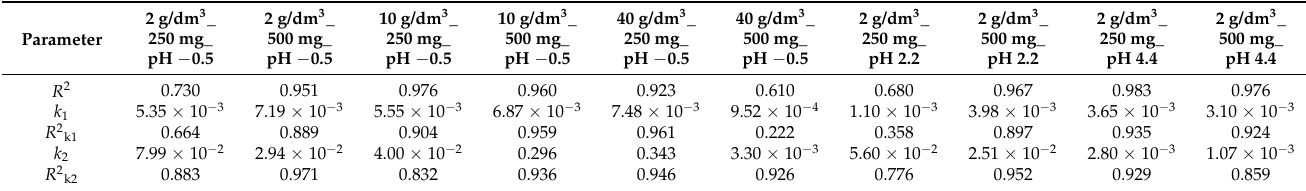
Table 5. The PFO and PSO kinetic parameters for MAC-3 (abbreviation: initial concentration of Cr(III)_mass of